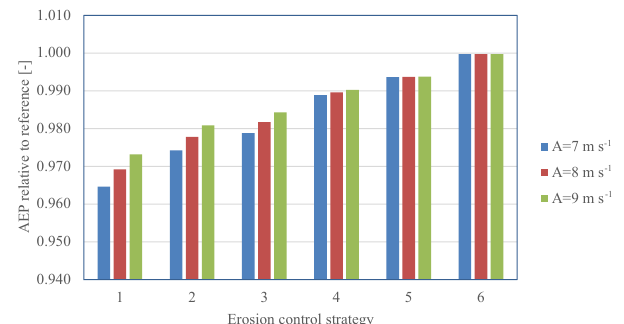
Figure 17. AEP relative to AEP with no erosion.